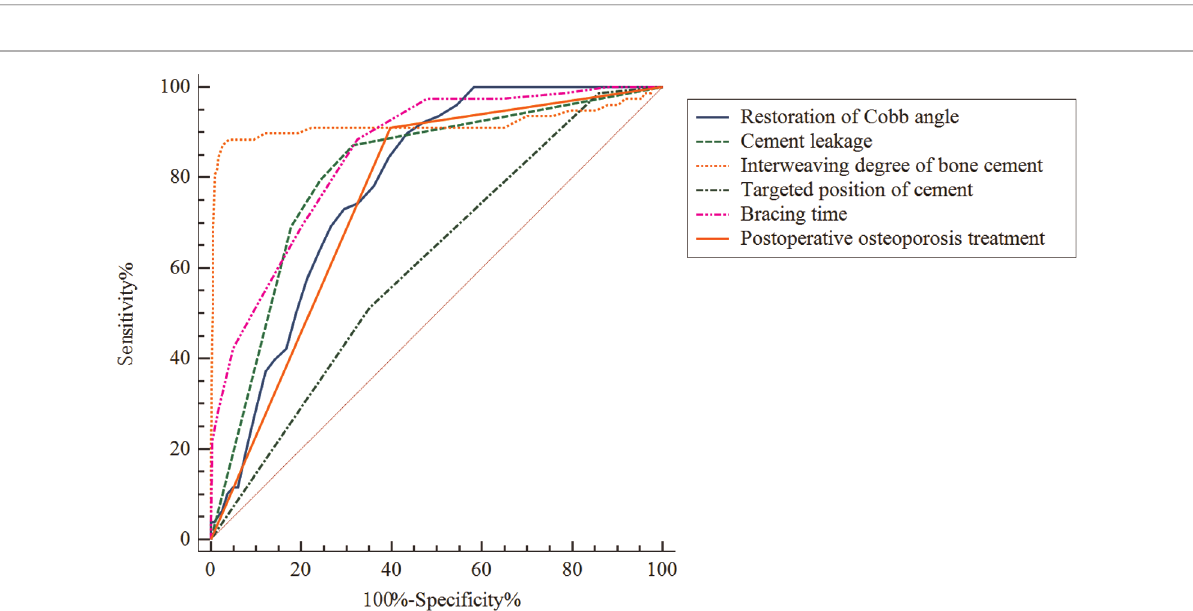
FIGURE 4 Receiver operating curves for the prediction performance of the multiple logistic regression